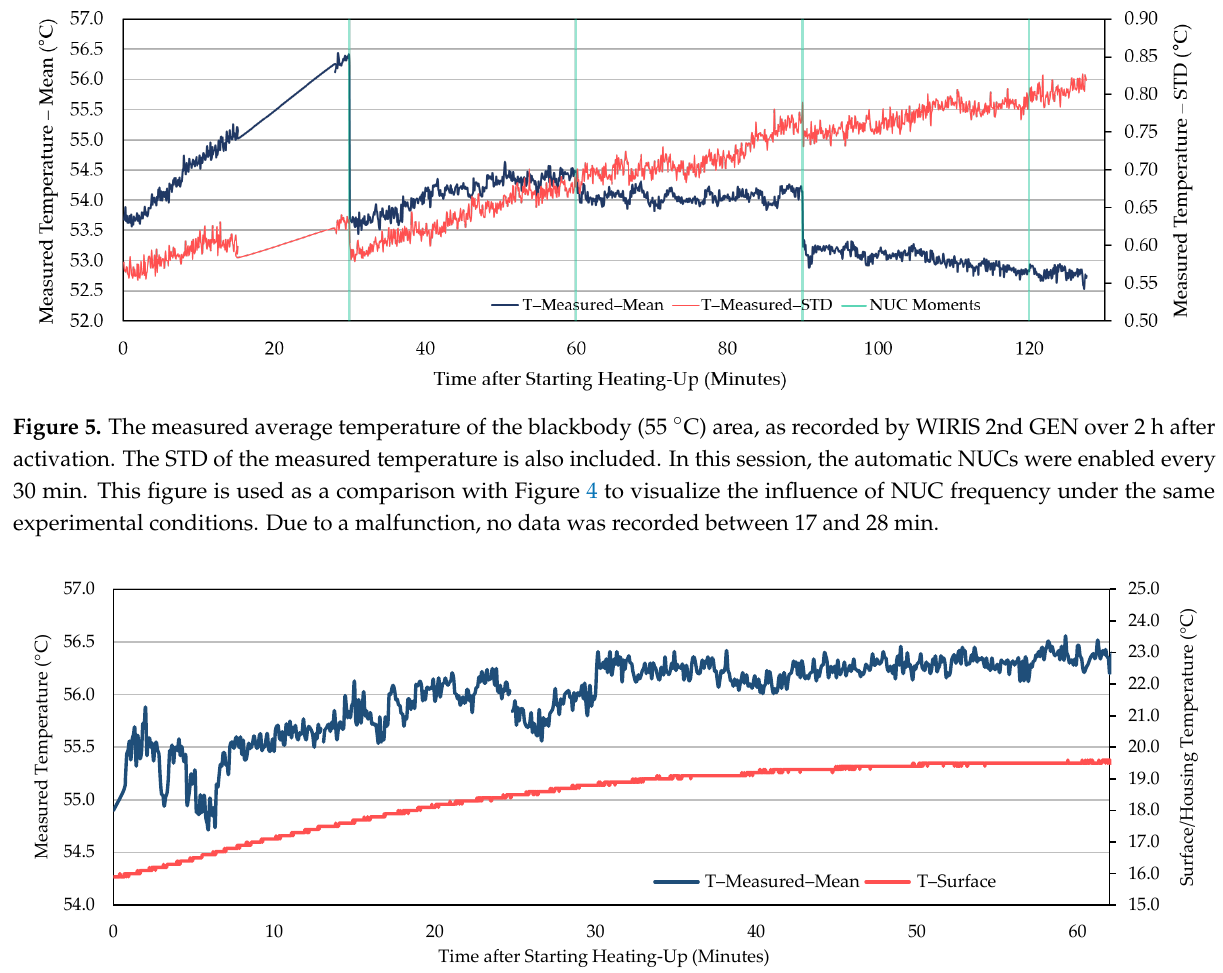
Figure 6. The measured average temperature of the blackbody calibrator (55 °C) area, as recorded by FLIR E8-XT over 1 h after switching on the camera. The housing temperature’s development of the camera is also depicted.